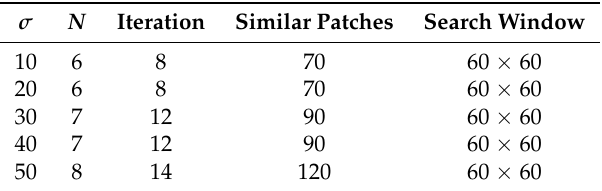
Table 3. Parameters of WNNM.